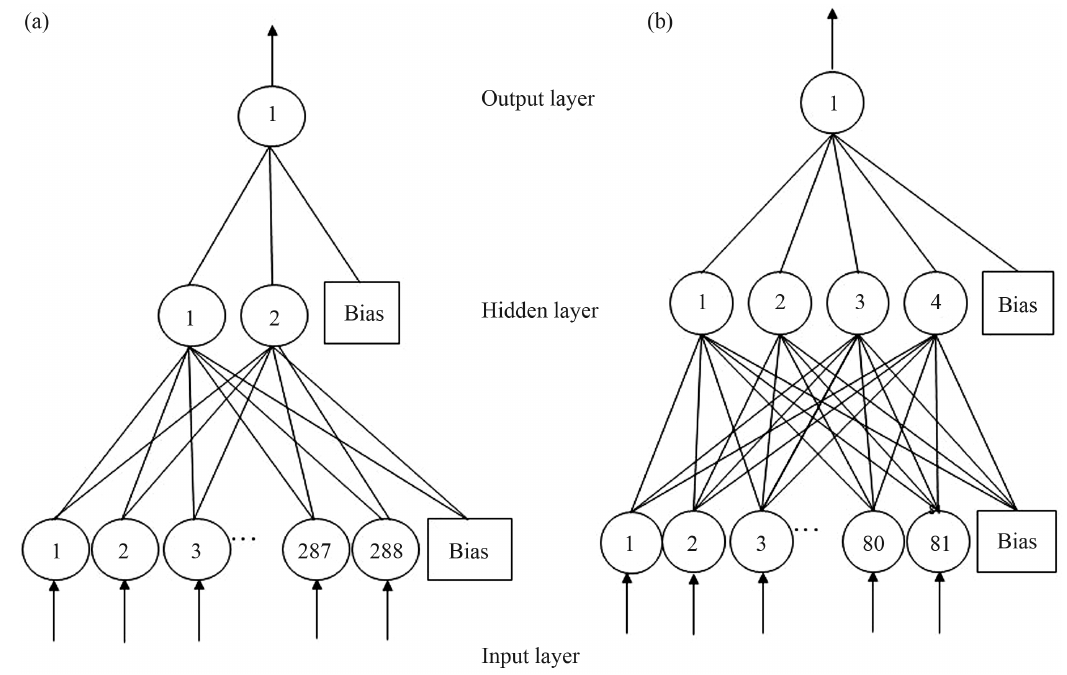
Figure 2 - (a) Architecture of the best NN used to classify promoter sequences in the sequence-based simulation. There were 288 neurons in the input layer, two neurons in the hidden layer and one neuron in the output layer. (b) Architecture of the best NN used to classify promoters in the stability-based simulation. There were 81 neurons in the input layer, four neurons in the hidden layer and one neuron in the output